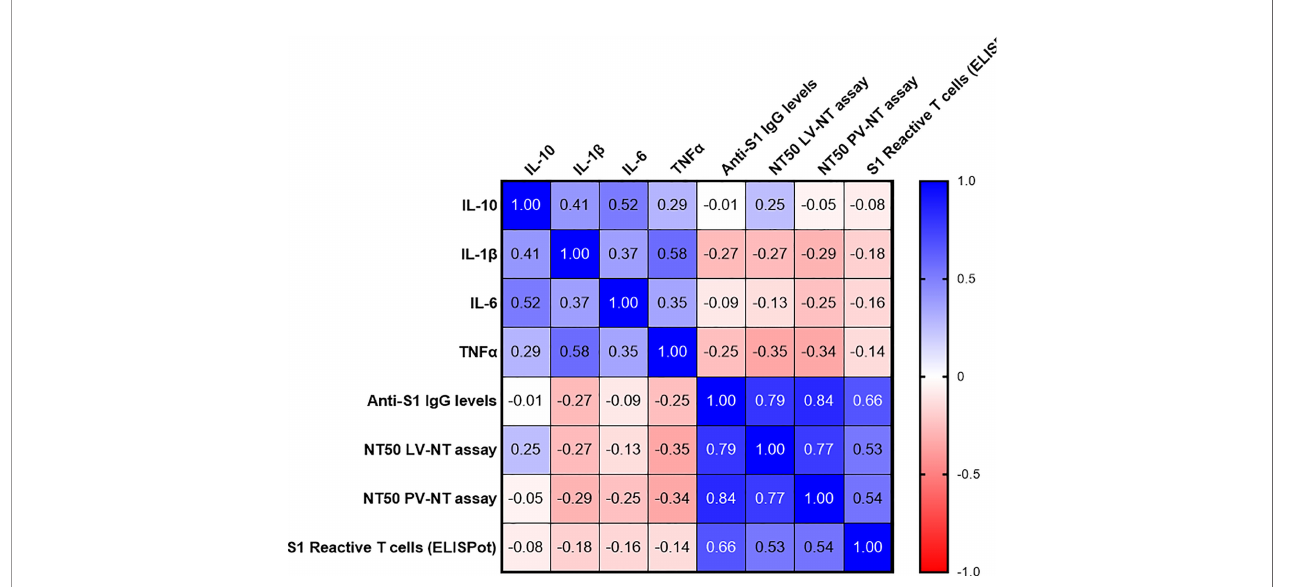
FIGURE 8 | Correlations between plasma cytokines levels at baseline, and main immune parameters of the postvaccinal response at 3 months in COVID-19-naive older subjects. The values correspond to Spearman ’ s rank correlation ( r ) coef fi cients. Only two correlations were found to be signi fi cant, between TNF a levels and NT50 LV-NT ( r (95% CI) − 0.35 [ − 0.62; 0.007], p = 0.048, sample size n = 33) and between TNF a levels and NT50 pV-NT ( r (95% CI) − 0.34 [ − 0.60; 0.02], p = 0.034, sample size n = 38). AIM + , cell-expressing activation-induced markers; NT50 LV-NT assay, 50% serum neutralization titer in live virus neutralization assay; NT50 PV- NT assay, 50% serum neutralization titer in pseudovirus neutralization